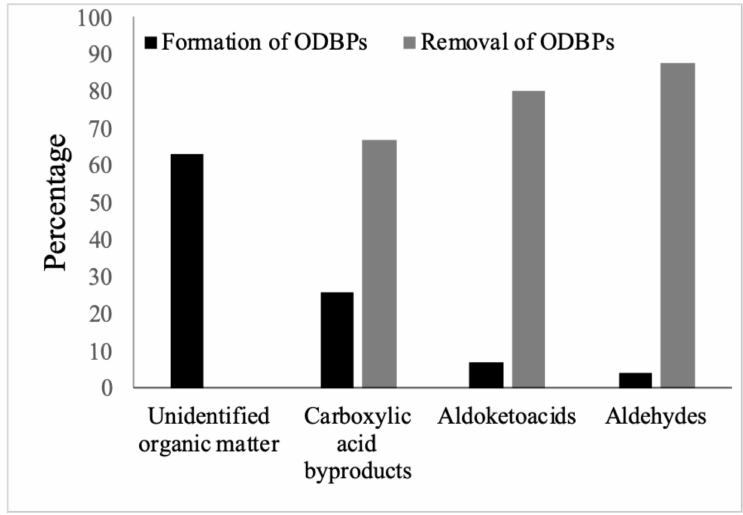
Figure 1. Percentage of formation and removal of disinfection by-products identified during ozonation in drinking water samples